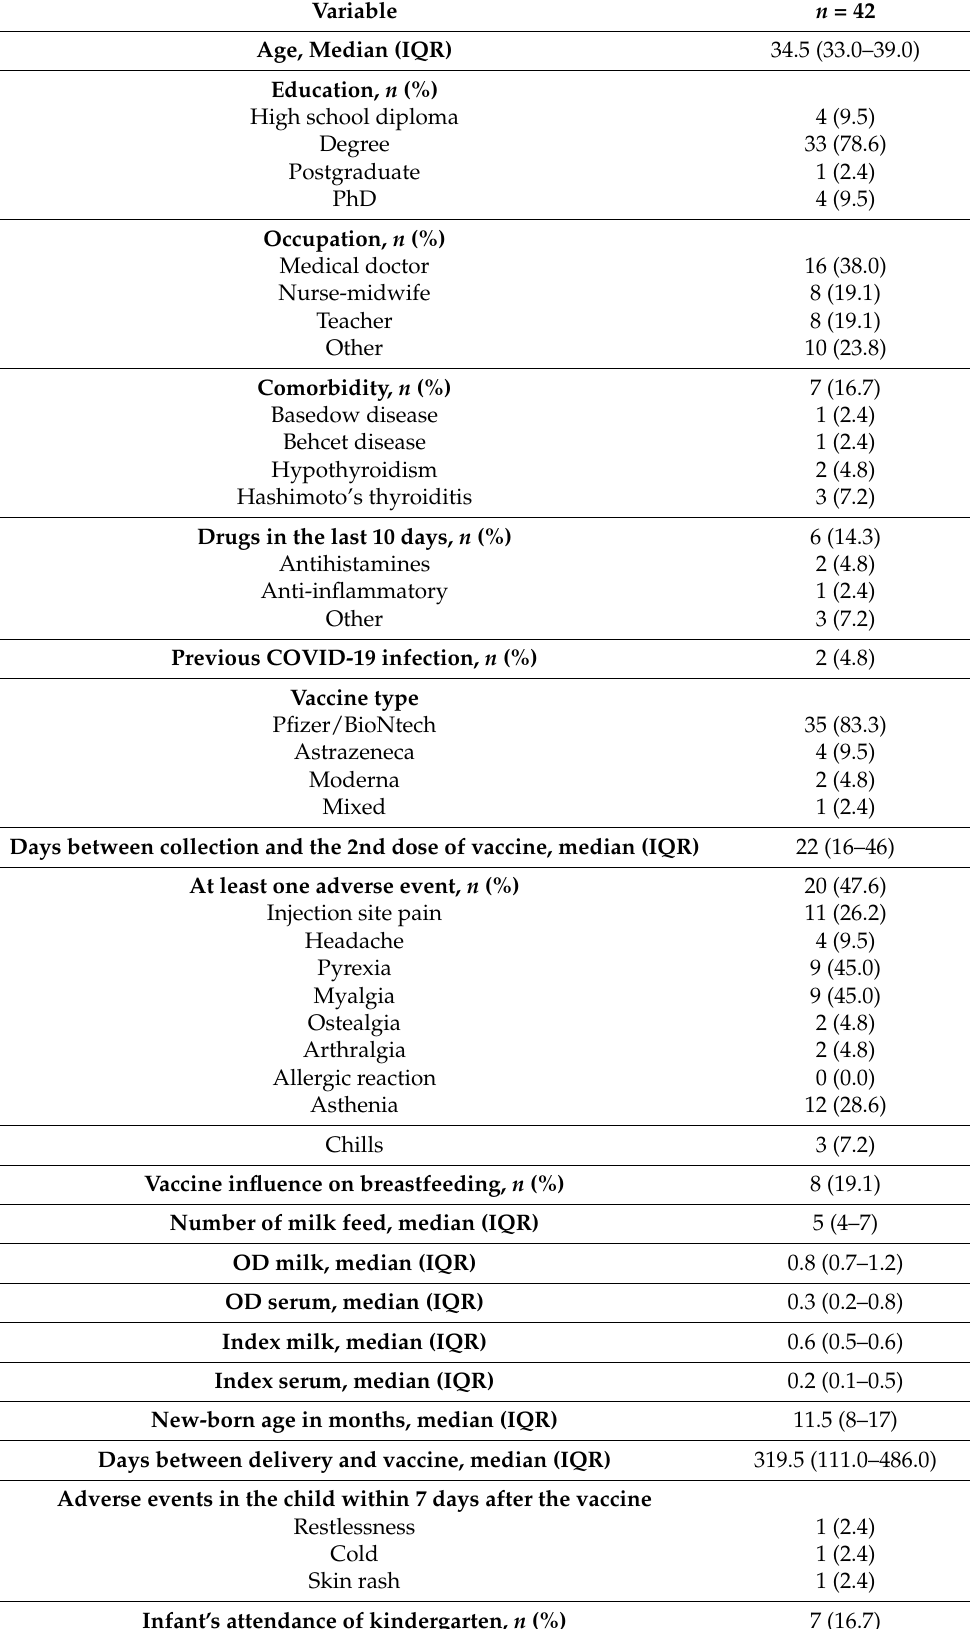
Table 1. Characteristics of the